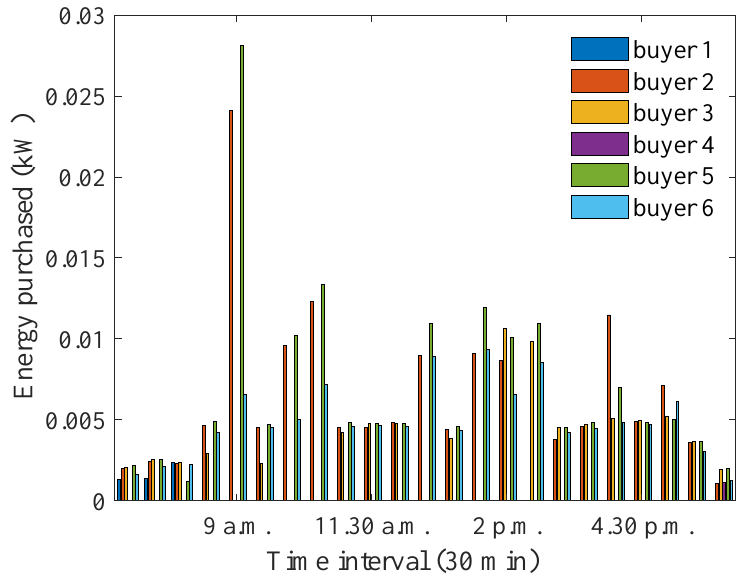
Figure 21. Optimum energy purchased when distance between house 4 and the aggregator is decreased.